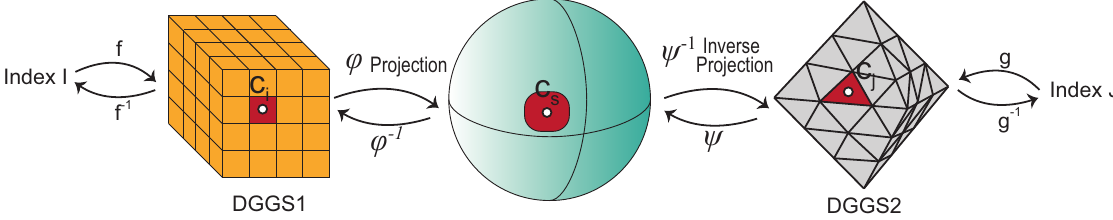
Figure 11. Index I in Discrete Global Grid System 1 (DGGS1) is mapped to the refined polyhedron by mapping f . The cell is then projected to the sphere by the projection ϕ used in DGGS1. Then, the centroid of cell I is inverse projected by the inverse projection ψ − 1 of DGGS2. The index J in DGGS2 is then found using inverse mapping g − 1